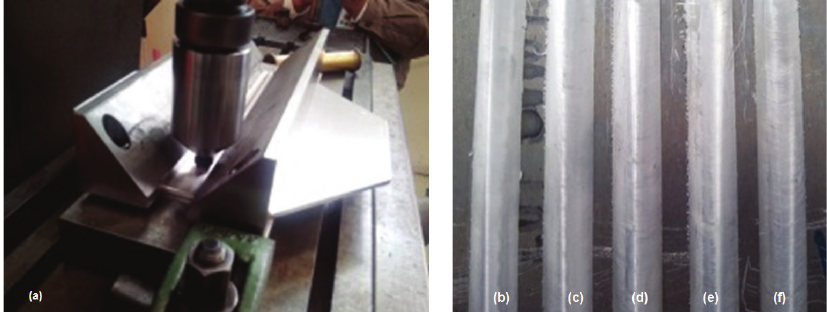
Figure 18: FSP of a large size sheet with a special device at 733 rpm; (a) special device in conventional milling, (b) 224 mm/min, (c) 168 mm/min, (d) 123 mm/min, (e) 88 mm/min, and (f) 65 mm/min.